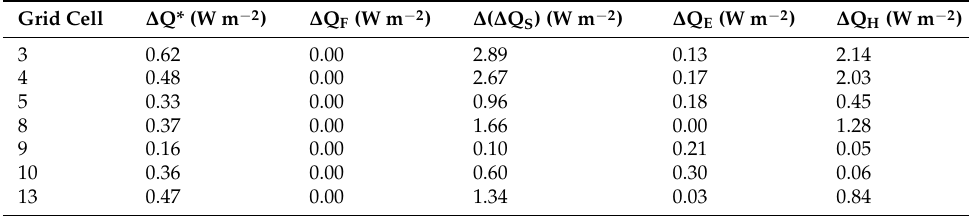
Table 5. Absolute mean flux differences per grid (baseline-error model run).